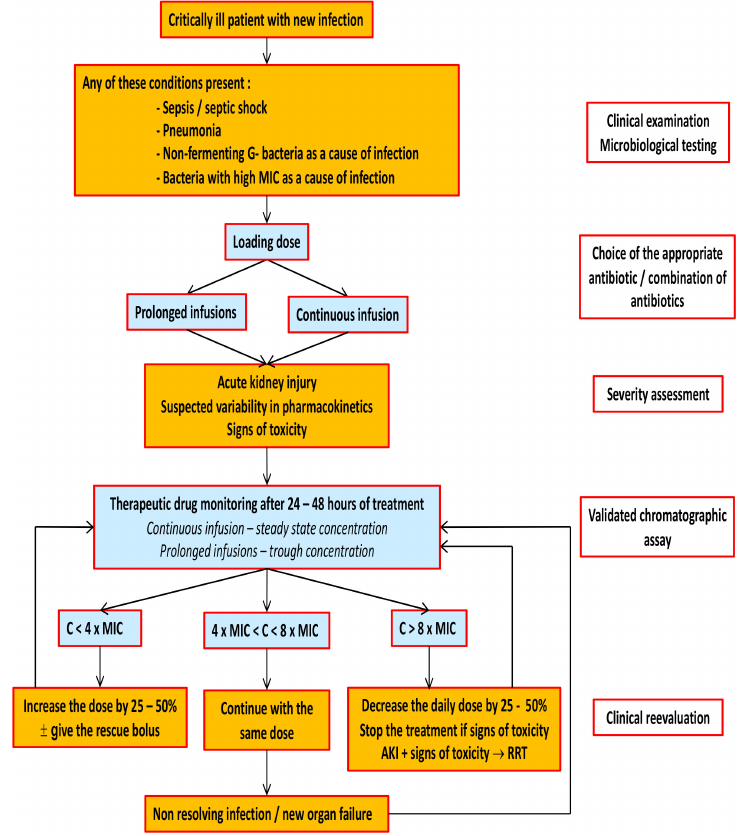
Figure 1. Simple algorithm utilizing therapeutic drug monitoring. “High MIC” for a given beta- lactam antibiotic denotes a MIC value above the median of the distribution of MIC values for wild-type strains of the considered bacteria. G-bacteria: Gram-negative bacteria. Based on recom- mendations published previously [15]. Table 1. General characteristics of beta-lactam